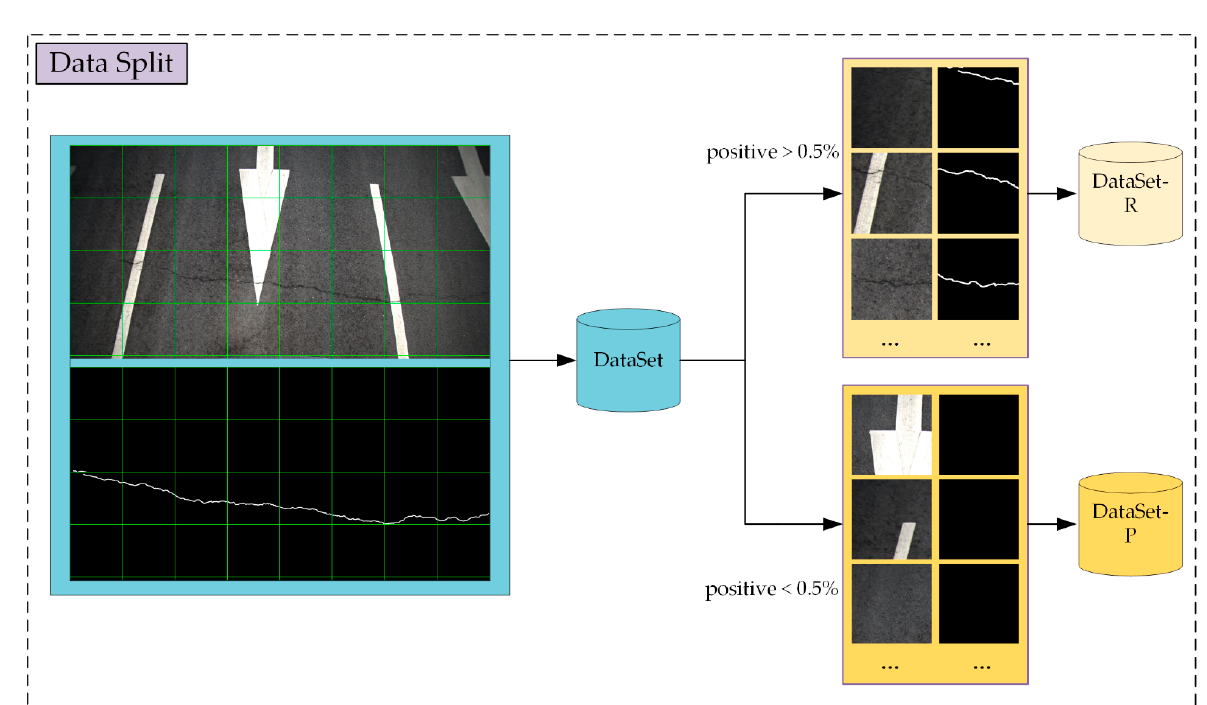
Figure 2. The dataset is divided into dataset R and dataset P.